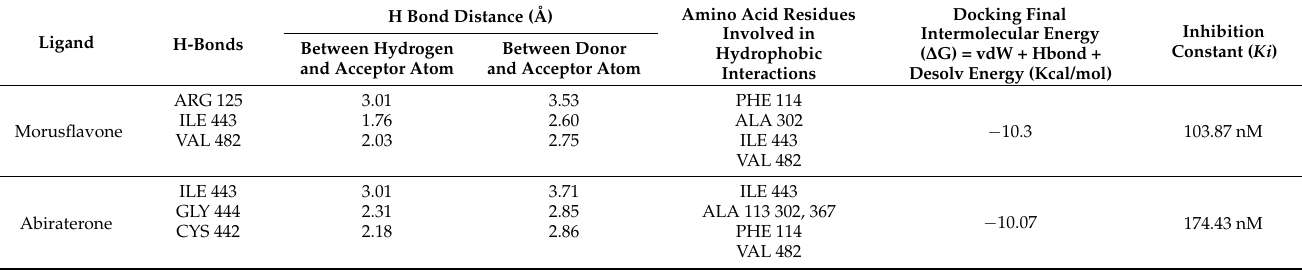
Figure 3. Abiraterone and its molecular interaction with CYP17A1. Table 1. Molecular interaction analyses with protein